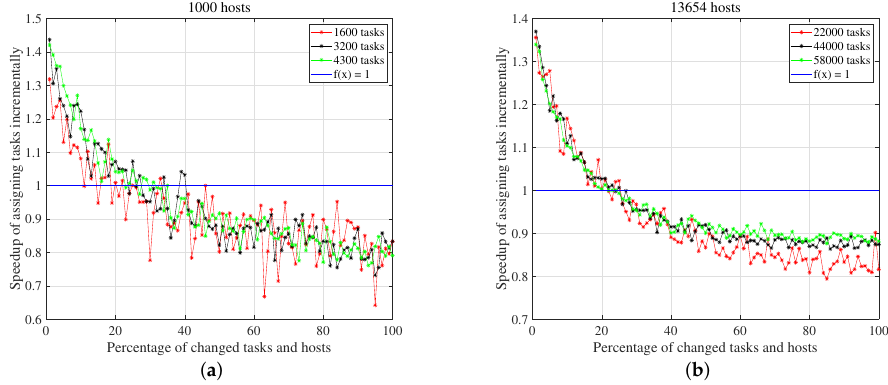
Figure 8. Speed-up of assigning tasks incrementally. ( a ) 1000 hosts. ( b ) 13,654